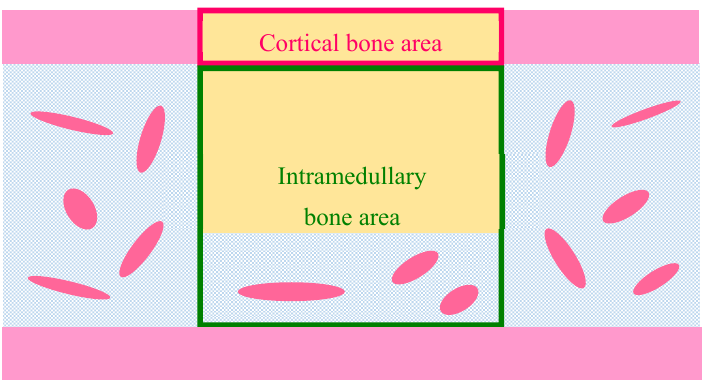
Figure 12. Schematic illustration of histomorphomeric measurement of newly formed bone [ n − Bone (%)] in the defect. Pink frame, cortical bone area; yellow rectangle, bone defect; green frame, intramedullary bone area.